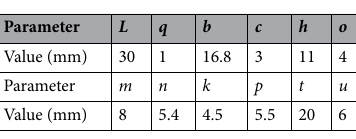
Table 1. Antenna parameters.